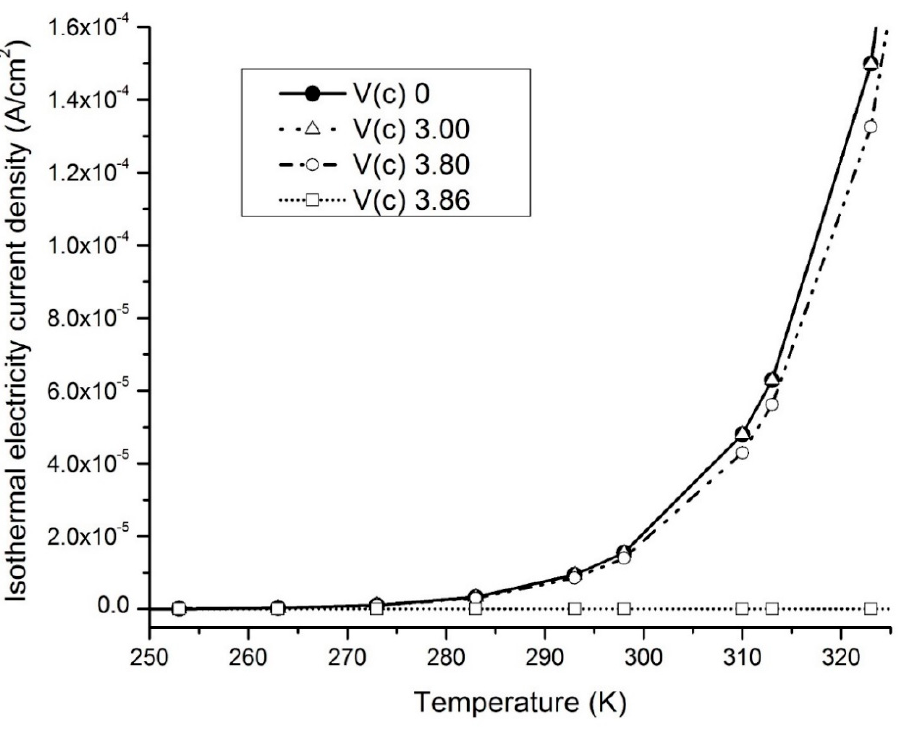
Figure 8. Presents the computed isothermal electricity current density (A/cm 2 ) as a function of operating temperature T at various output voltage V(c) from 0.00 to 3.86 V, as calculated using Equation (3) for a pair of low work function (0.70 eV) emitter and high work function (4.56 eV) collector; in which the emitter was